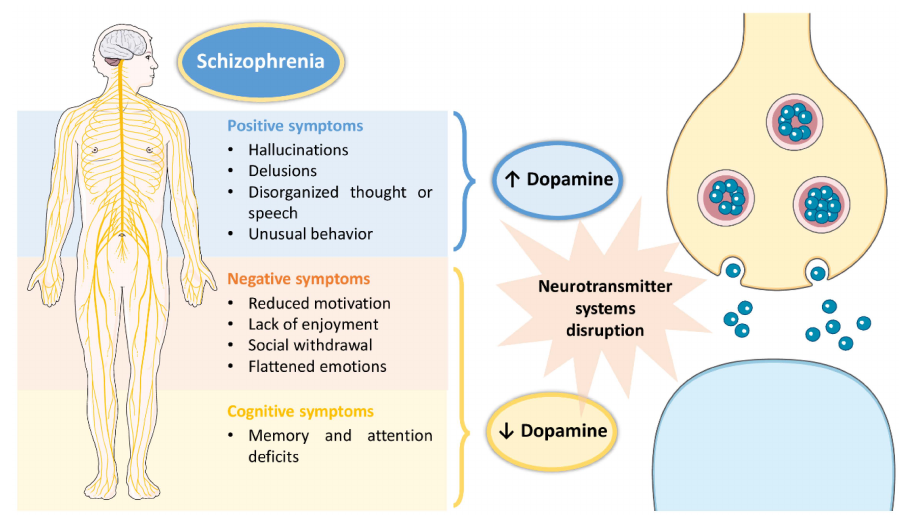
Figure 1. Pathophysiology of schizophrenia, including associated symptoms and pathological mechanisms at the cellular